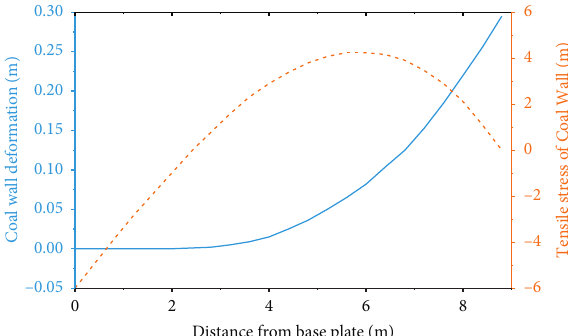
Figure 3: Displacement and stress distribution in the coal wall as a function of distance from the floor.